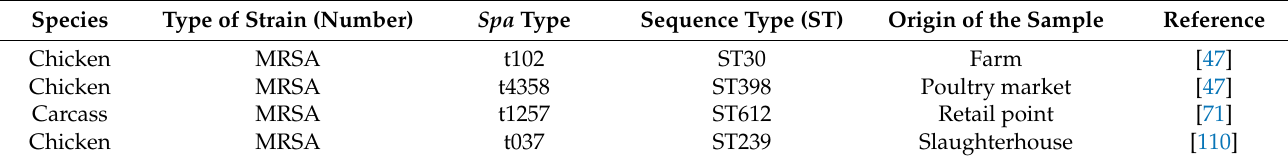
Table 11. Sequence tMype and spa type of different meat isolates from two African countries. Species Type of Strain